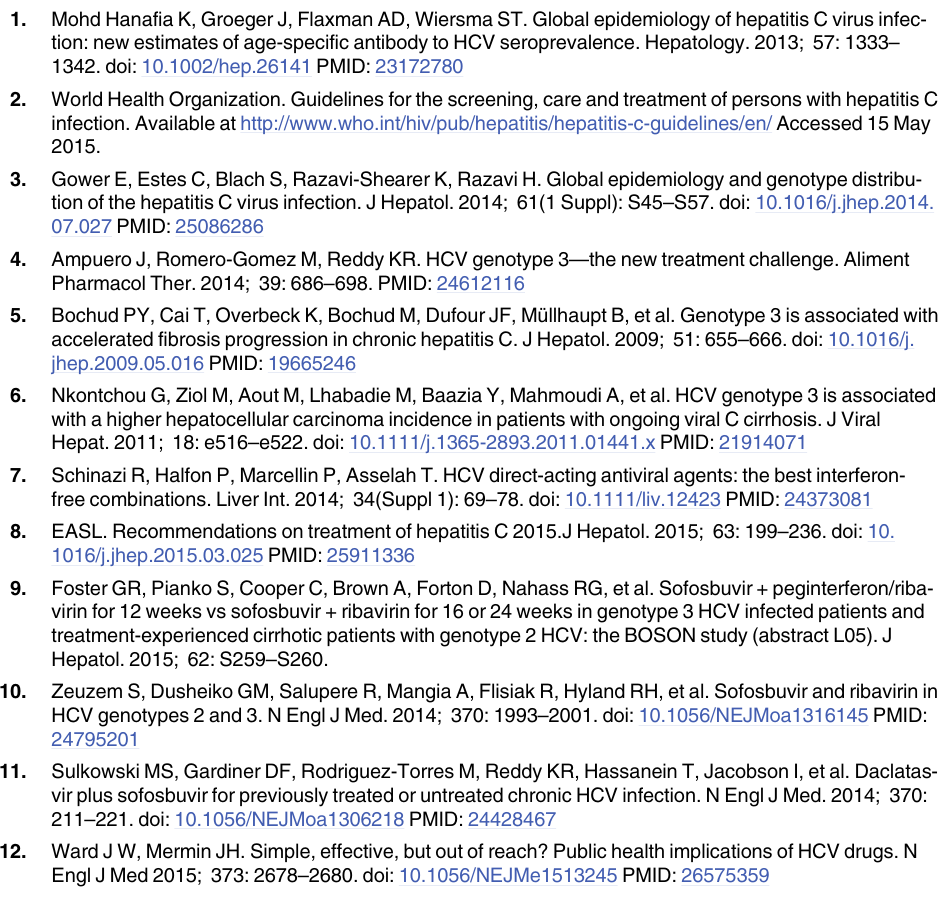
S2 Table. Patients ’ country of enrollment (validation cohort). S3 Table. Summary of logistic regression analysis. S4 Table. Sensitivity, specificity, positive predictive value and negative predictive value of the prediction score for SVR (development